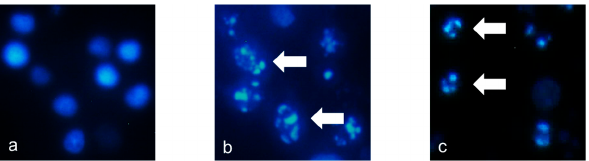
Figure 2. Representative fields showing the morphology of HL-60 cells stained with DAPI after the following treatments for 24 h (magnification, 200×): ( a ) control ( b ) 15 µM of etoposide, or ( c ) 10 µM of 11 . The arrows indicate fragmented and condensed nuclear chromatin.